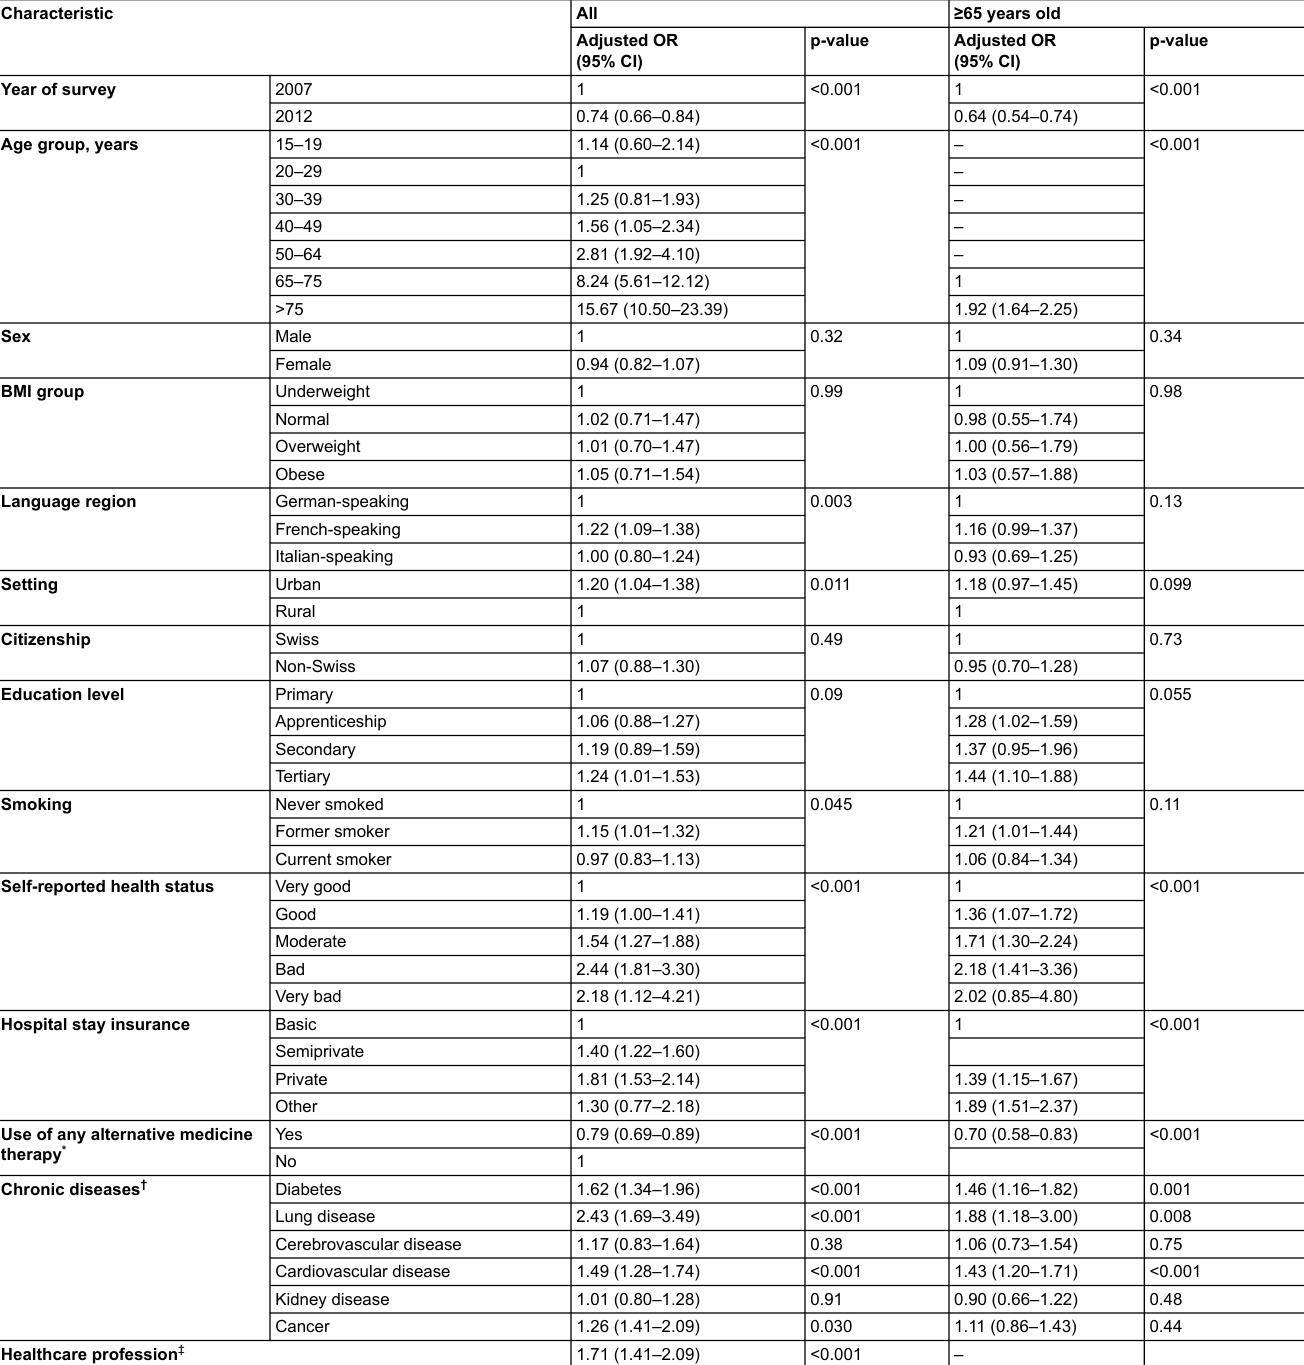
Table 2: Associations of having been vaccinated for influenza in the last 12 months with sociodemographic characteristics and health-related factors (as compared to no vacci- nation) in Switzerland, 2007 and 2012, overall and among people ≥65 years old.